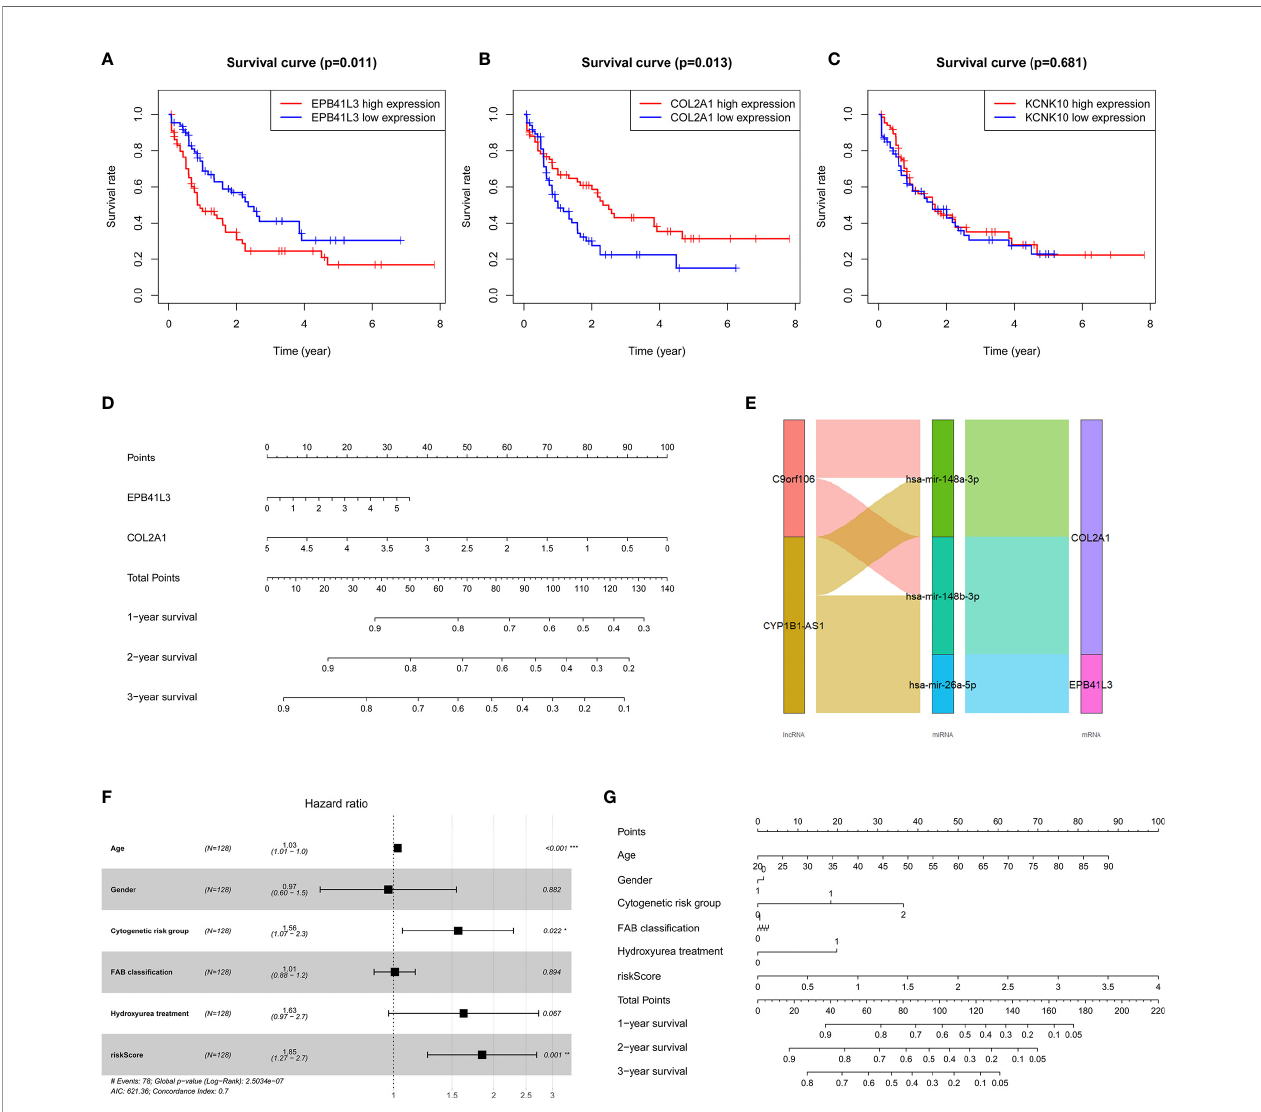
FIGURE 6 | Verifying the prognostic value of the three core mRNAs. (A – C) Survival curve of the three hub mRNAs: the survival rate of AML patients with high expression of EPB41L3 signi fi cantly decreased (P = 0.011), and the survival rate of AML patients with low expression of COL2A1 signi fi cantly decreased (P = 0.013). There is no signi fi cant difference in survival rate between different KCNK10 expression levels (P = 0.681), so we believe that EPB41L3 and COL2A1 are core prognostic mRNAs with predictive value. (D) Nomogram of EPB41L3 and COL2A1 based on the results of the multivariate Cox regression. (E) Hub prognostic ceRNA network based on EPB41L3 and COL2A1; (F) Forest map of multivariate Cox regression analysis: the risk score of prognostic model maintained independence in predicting the OS of AML patients (HR = 1.8469, 95% CI = 1.2652 – 2.6961, P = 0.00147). At the same time, age and cytogenetic risk groups of AML patients also have independent prognosis value. (G) The nomogram of the risk score of prognostic model and clinic characters.